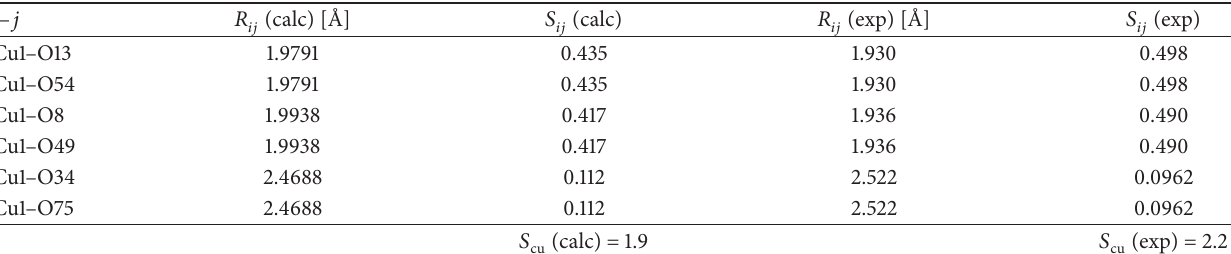
Table 4: Bond and copper valence data for